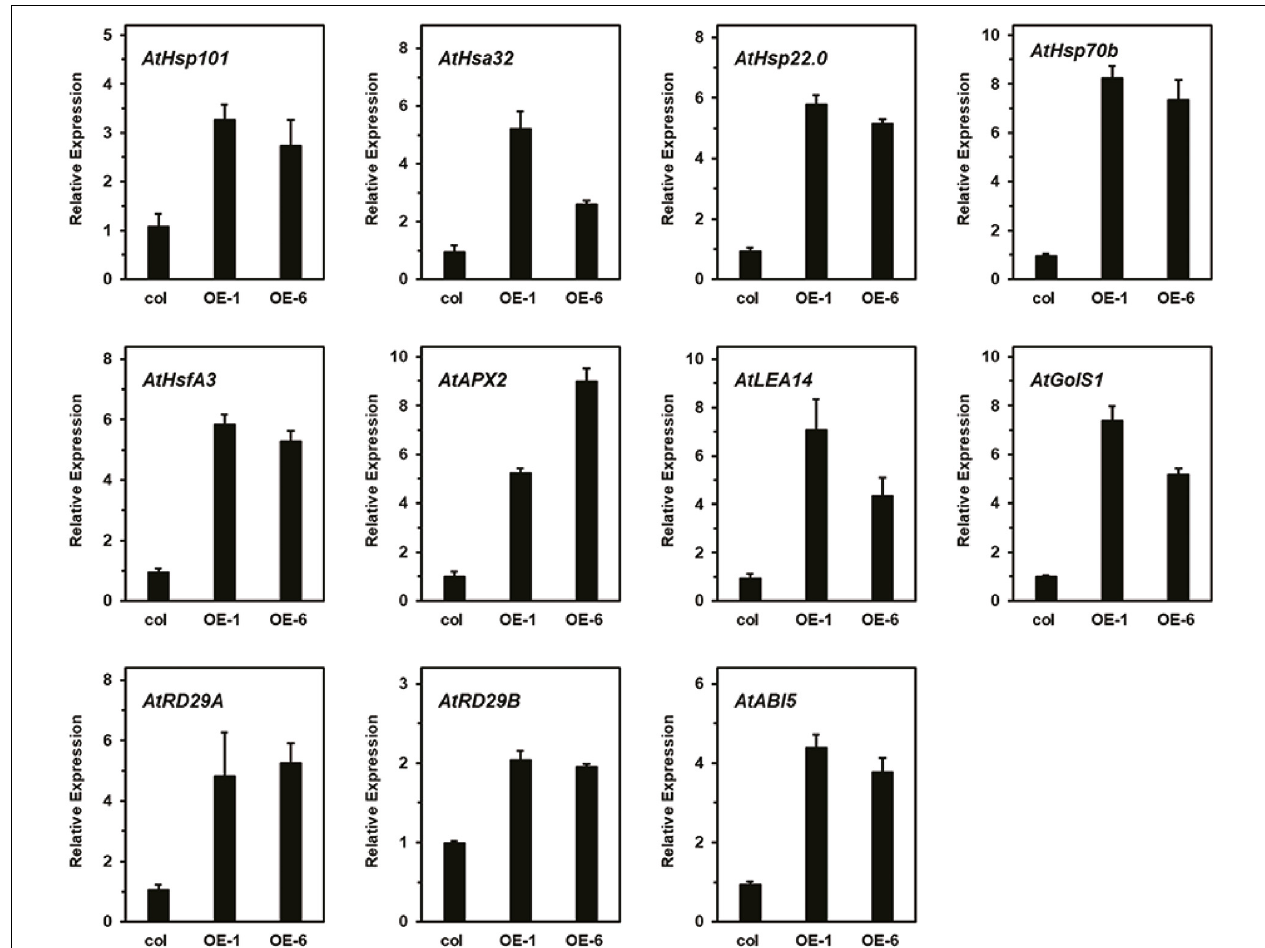
FIGURE 10 | Relative expression level of AtDREB2A target genes, HS-responsive genes, and ABA-related genes in transgenic plants. Raw data were normalized using AtActin2 as an internal reference. Data represent means ± SD of three independent